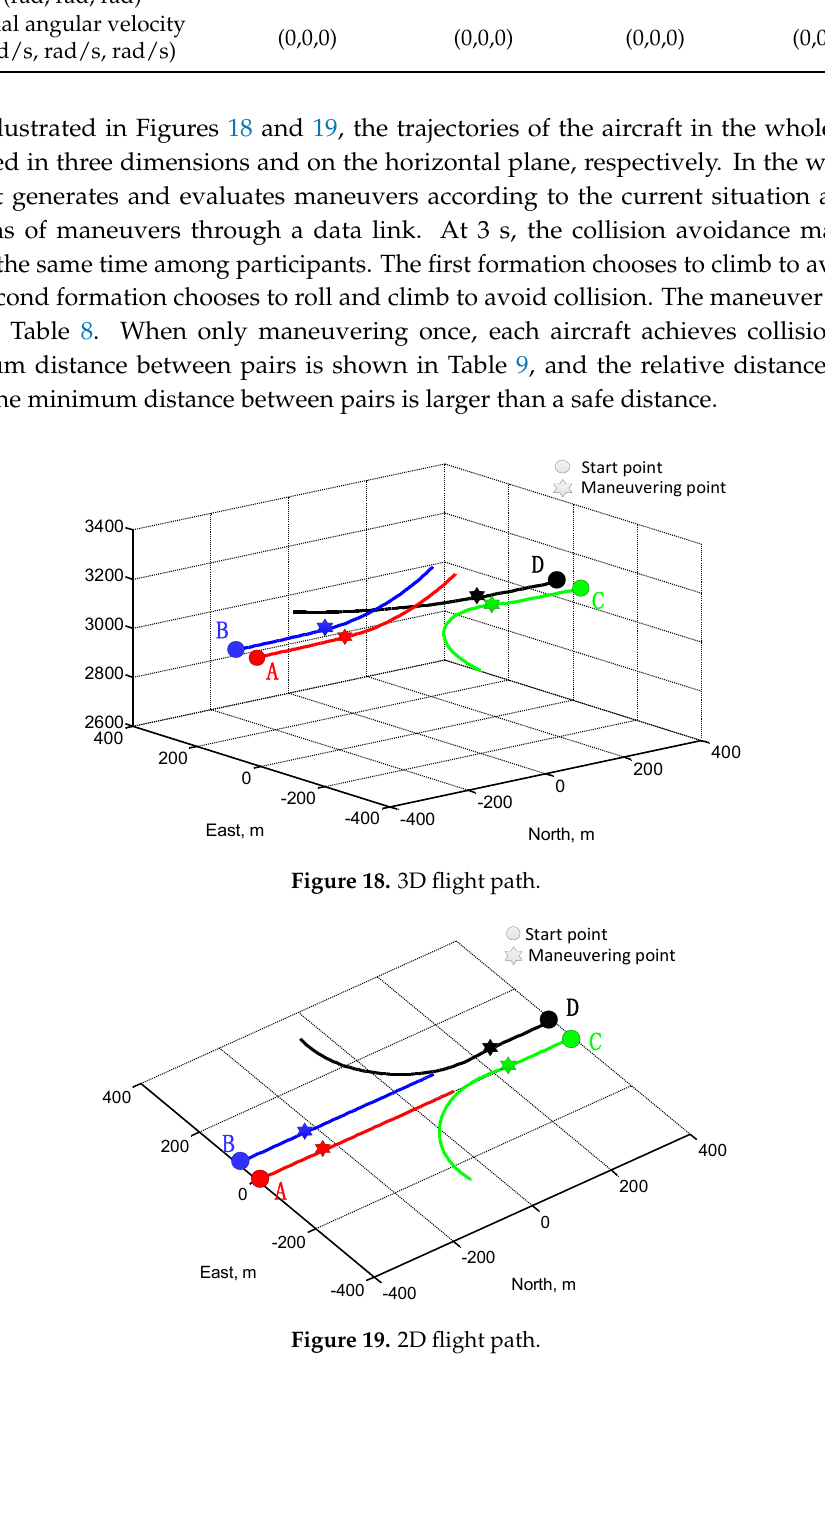
Table 7. Initial state.